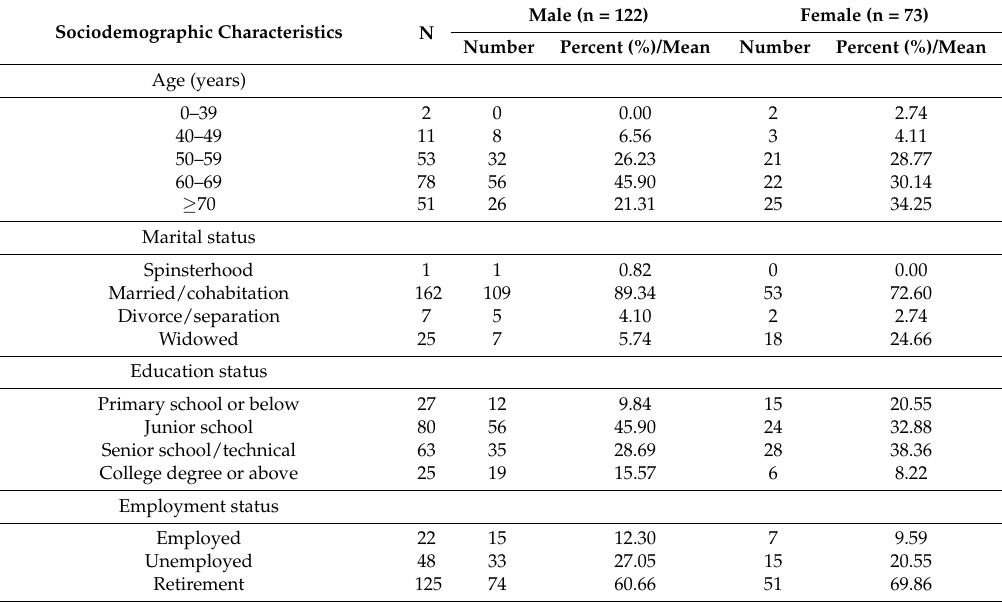
Table 1. Sociodemographic characteristics of 195 lung cancer